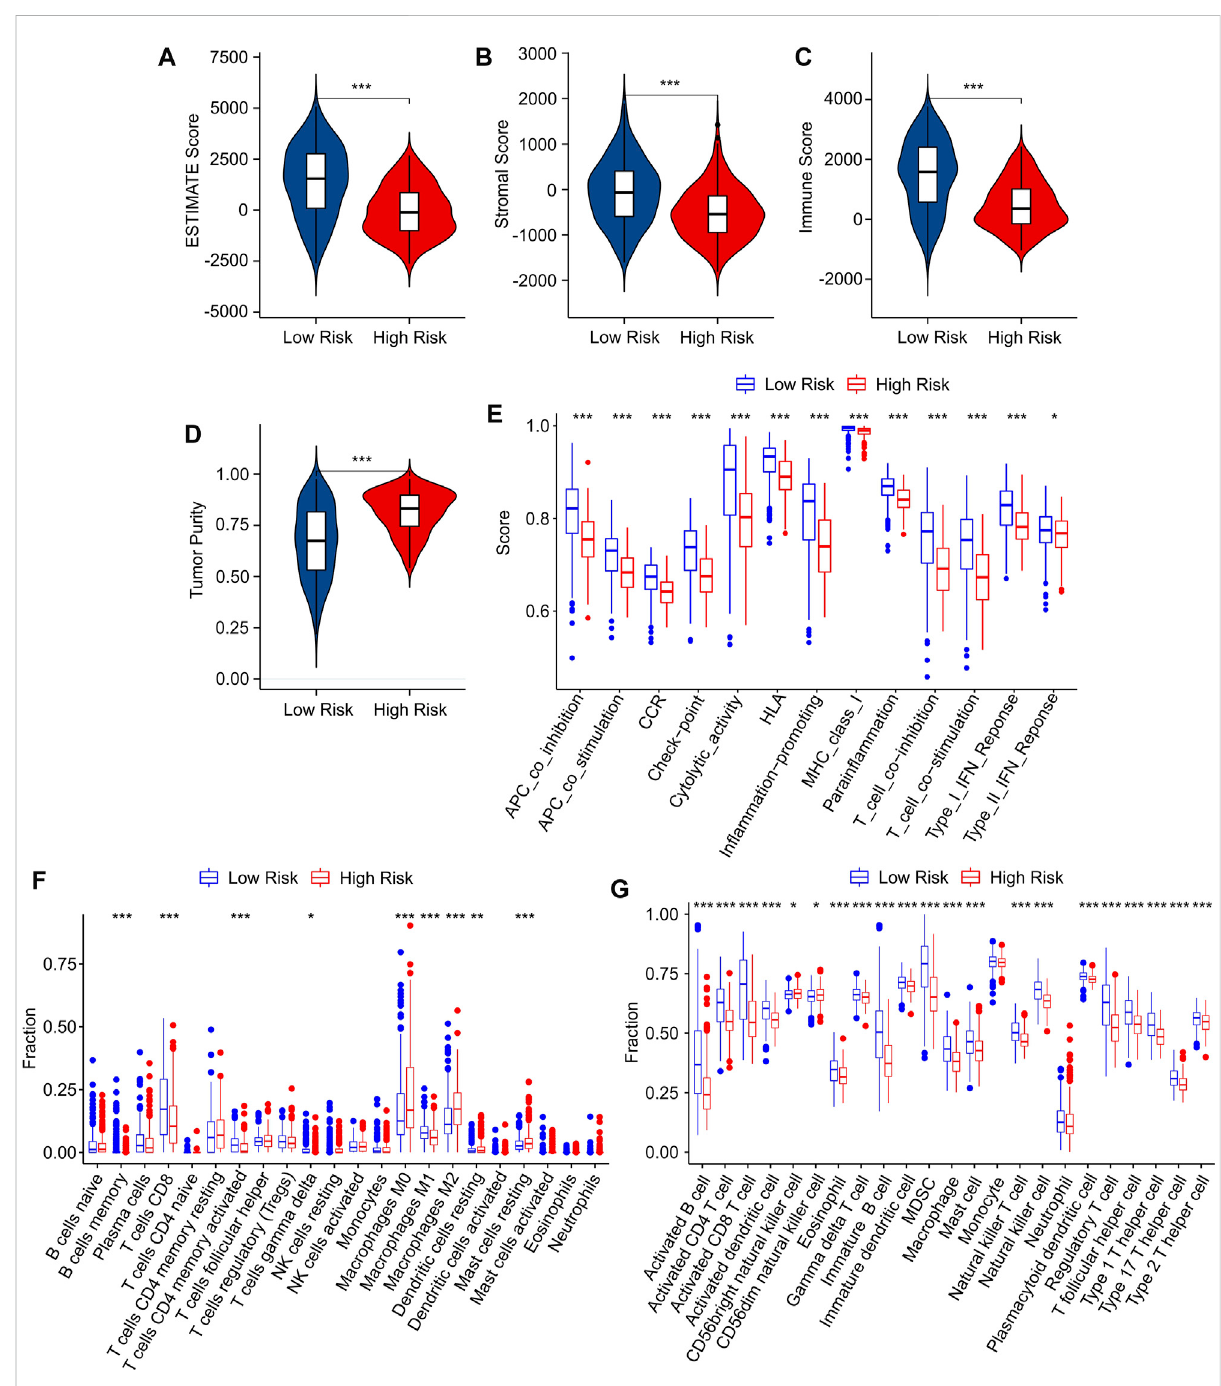
FIGURE 7 Immunein fi ltrationcharacteristicsofCMpatientsinthelow-andhigh-riskgroup. (A) ESTIMATEscore. (B) Stromalscore. (C) Immunescore. (D) Tumor purity. (E) The immune function score of patients in low- and high-risk groups. (F) The fraction of 22 immune cells in the low- and high-risk groups calculated by CIBERSORT algorithm. (G) The fraction of 23 immune cells in the low- and high-risk groups calculated by ssGSEA